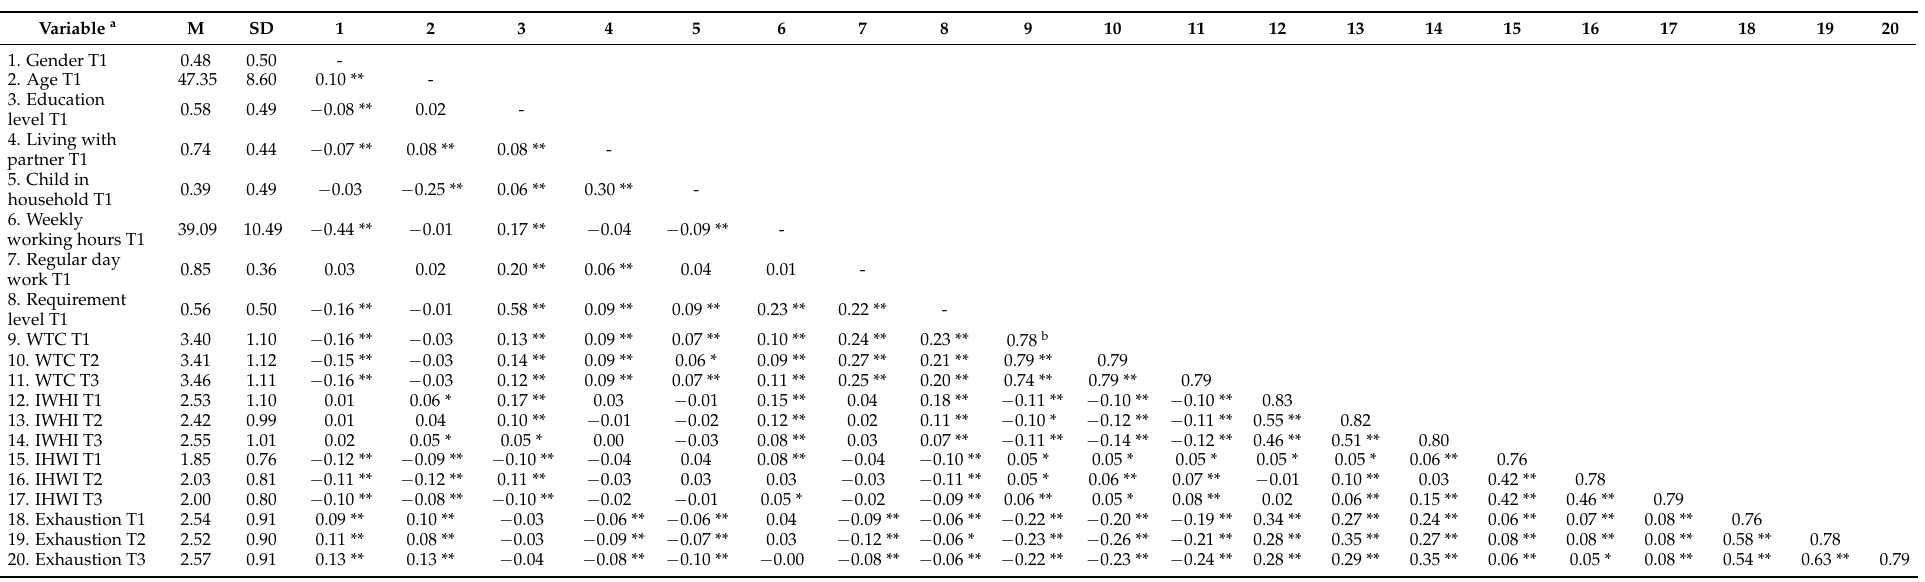
Table 1. Descriptive statistics, internal consistencies, and correlations among study variables ( n =